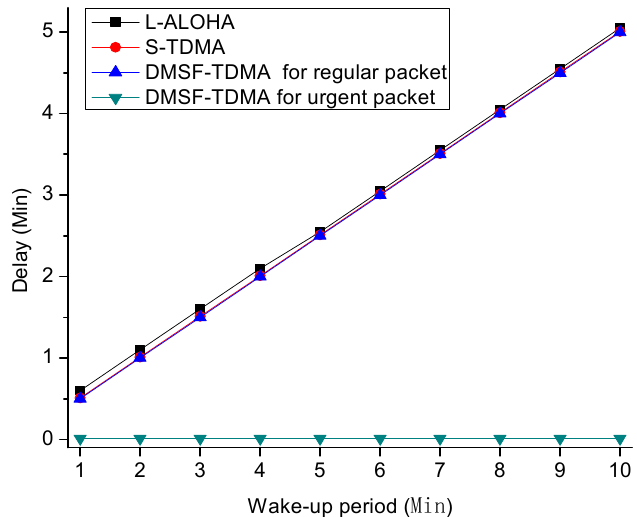
Figure 15. Average delay with different wake-up periods.